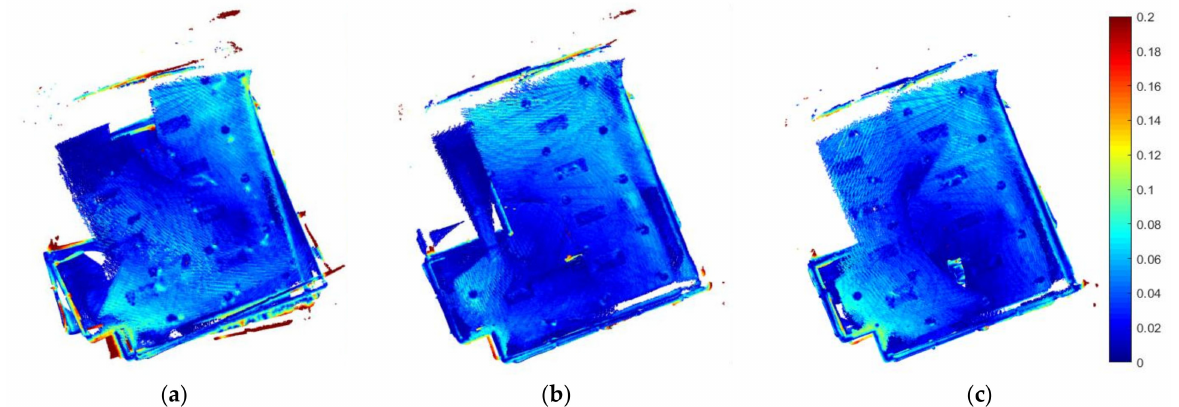
Figure 4. Low-texture PTPD (m) between exploration models and the ground truth model. ( a ) D strategy, ( b ) M strategy, and ( c ) M+D